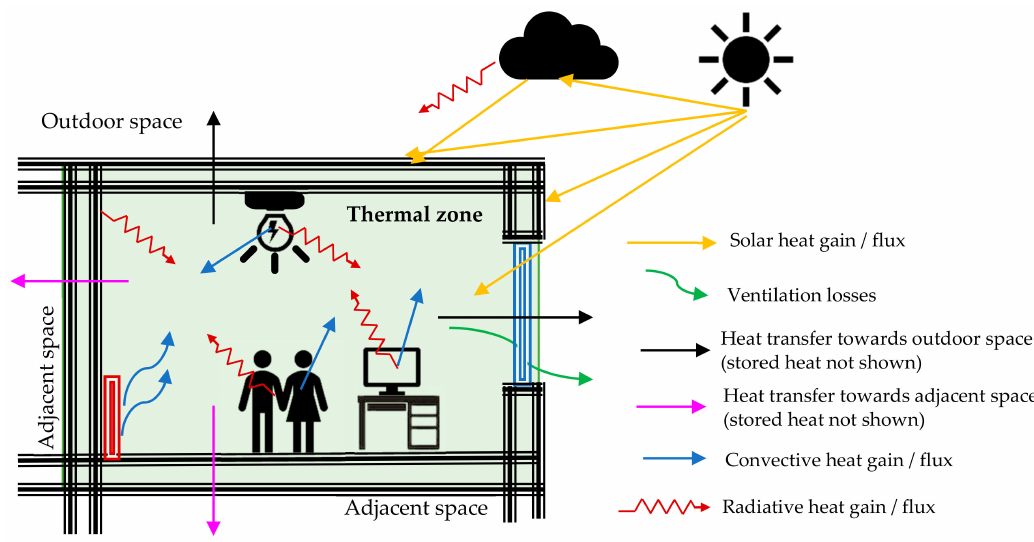
Figure 3. Illustrative scheme of the main energy / heat fluxes a ff ecting the building energy balance (stored energy contributions are not